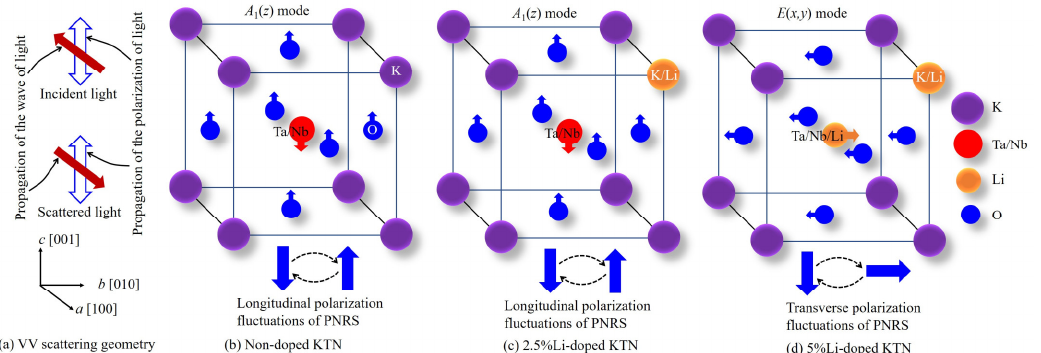
Figure 7. ( a ) A typical depiction of the VV scattering geometry. A schematic interpretation of the polarization fluctuations of PNRs caused by A 1 (z) mode in ( b ) non-doped KTN, ( c ) 2.5%Li-doped KTN, and E ( x,y ) mode in ( d ) 5%Li-doped KTN crystals observed in the VV scattering under the condition of fixed A-site cations [103].